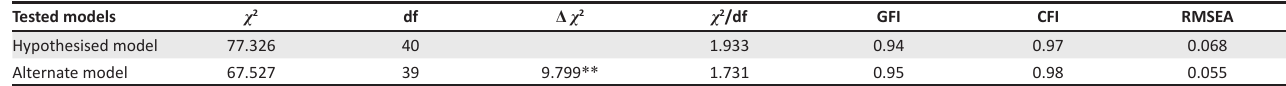
TABLE 5: Estimation indices for tested models. Tested